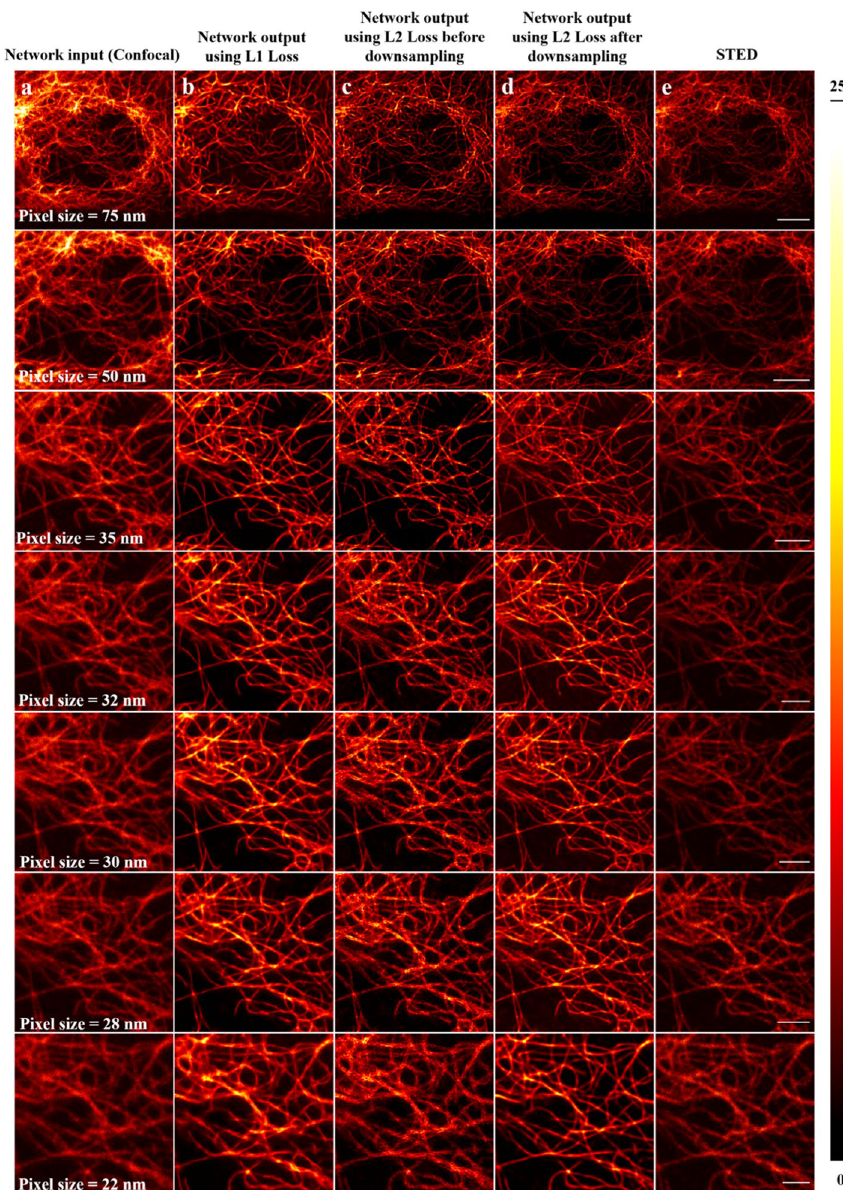
Fig. 5 ( a ) Diffraction-limited confocal microscopy images with different pixel sizes are used as input to the network. ( b ) The Super-resolved network inference images using L1 loss before upsampling/ downsampling the input images to match the pixel size of the training data. ( c ) The Super-resolved network inference images using L2 loss before upsampling/downsampling the input images to match the pixel size of the training data. ( d ) The super-resolved network inference images using L2 loss after upsampling/ downsampling the input images to match the pixel sizes of the training data. ( e ) The STED images of the same field of view. Scale bars in ( e ) are 8 μm, 6 μm, 4 μm, 3 μm, 3 μm, 3 μm and 2 μm, respectively from the first row to the seventh